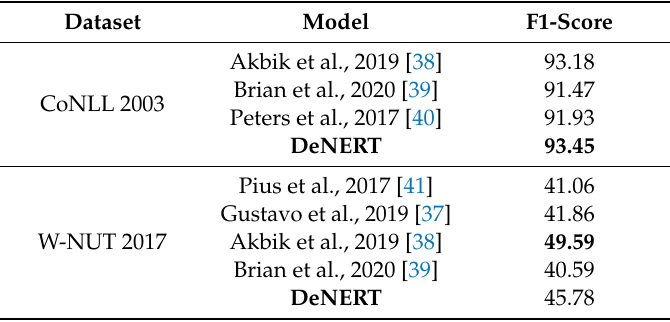
Table 5. Comparison result on CoNLL 2003 and W-NUT 2017 dataset.